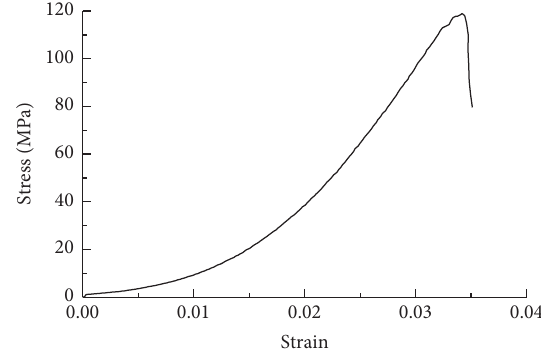
Figure 9: Stress-strain curve of sandstone under static load.